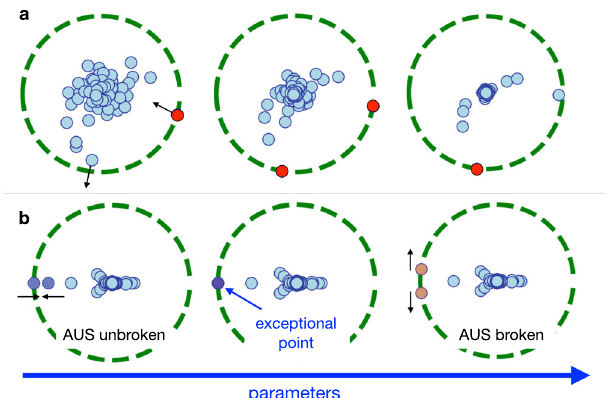
Fig. 3 Schematic of eigenvalue dynamics of the spacetime-dual operator ~ U . a Typical eigenvalue dynamics (small circles) near dynamical quantum phase transition (DQPT). Green dashed circles have the radius that corresponds to the eigenvalue(s) with the largest modulus. The eigenvalue with the largest modulus (red circles) switches at the critical point, at which two eigenvalues have the same modulus. b Eigenvalue dynamics through the exceptional DQPT. Eigenvalues with the largest and the second-largest modulus lie on the same radial direction protected by antiunitary symmetry (AUS) of ~ U when AUS is unbroken. When the parameter changes, the eigenvalues coincide at the critical parameter and show spectral singularity as an exceptional point. They then form a complex-conjugate pair (i.e., AUS breaking) and the modulus of two eigenvalues becomes equivalent. Table 1 Summary of antiunitary symmetry (AUS) classes. Only Class AI can exhibit the AUS-breaking transition.